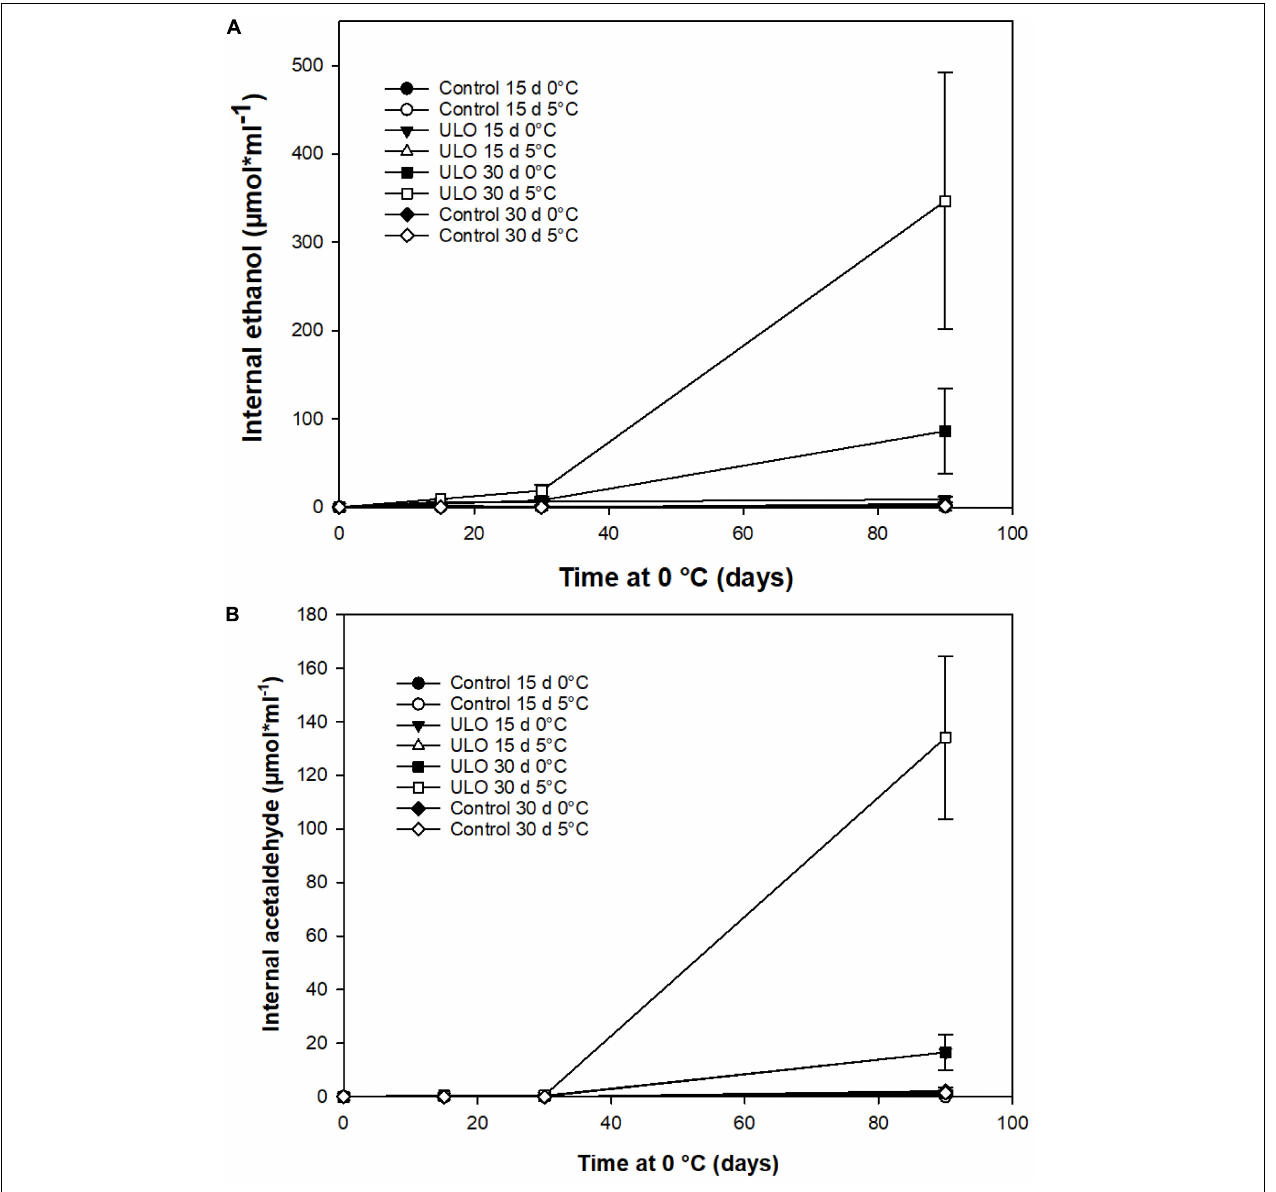
FIGURE 5 | Effect of ULO conditioning treatments for 15 and 30 days at 0 or 5 ◦ C on internal concentrations of ethanol (A) and acetaldehyde (B) in ‘Fuji’ apples stored for 90 days at 0 ◦ C. Values are means ± standard error, n = 4 replicates. ULO, ultra-low oxygen conditioning treatment; Control, conditioning temperature treatment under air